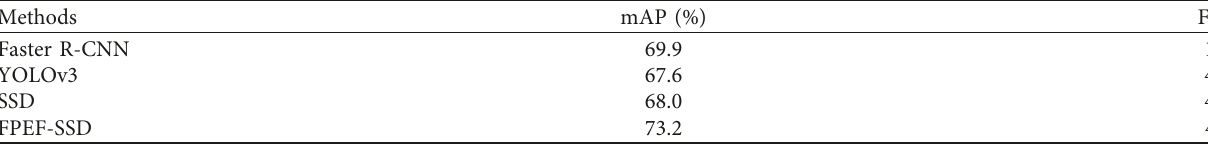
Table 2: Comparison of mAP and FPS results of Pascal VOC 2007.